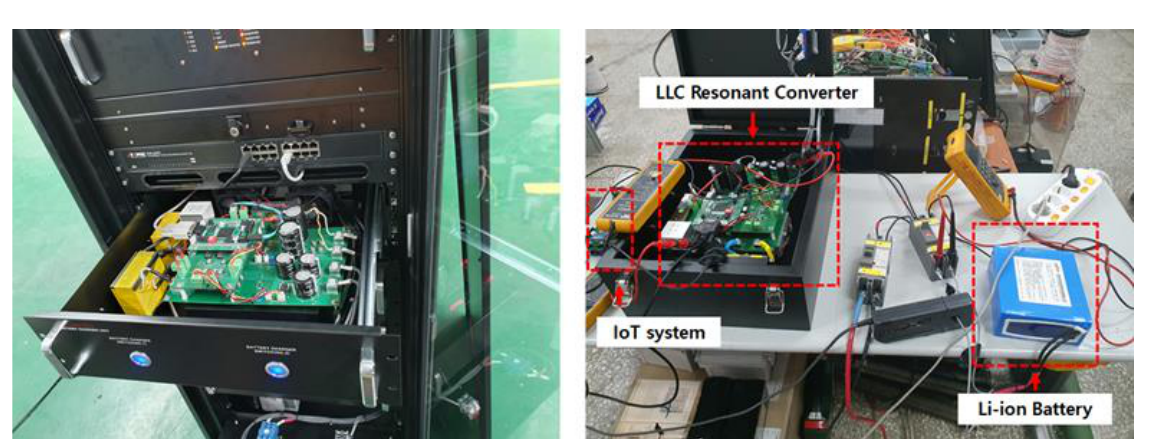
Figure 8. The prototype of the proposed system.